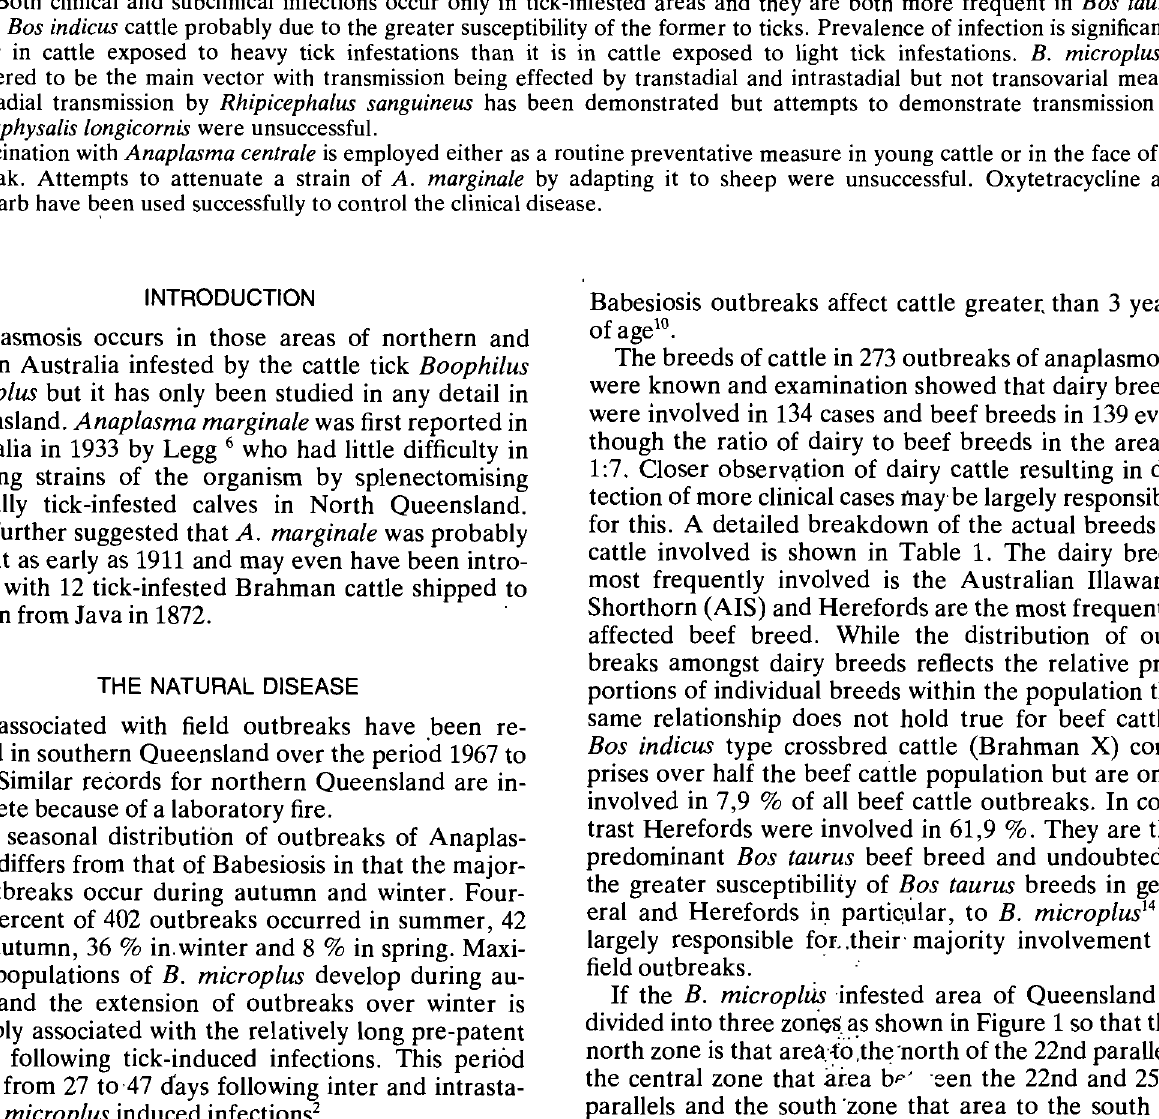
Table 1: BREEDS OF CATTLE INVOLVED IN 273 CLINICAL OUTBREAKS OF ANAPLASMOSIS IN SOUTHERN QUEENSLAND FROM 1967 TO 1978 INCLUSIVE Dairy Cattle Beef Cattle Breed Number %